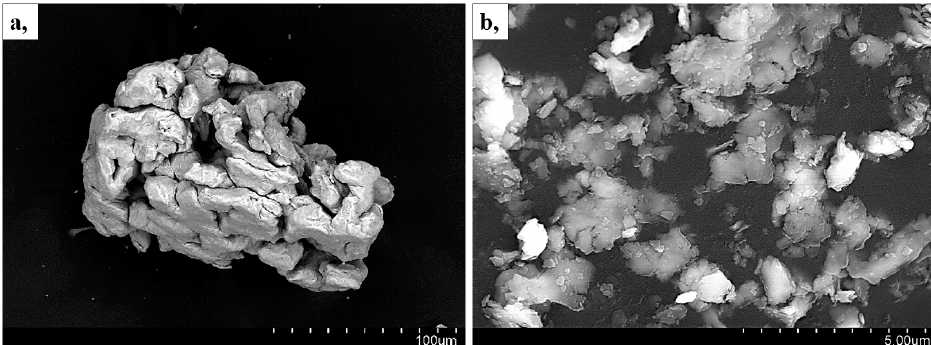
Figure 2. ( a , b ) Show the morphology of the initial and the milled Ti powders, respectively. Table 2. Chemical composition of initial and milled Ti powder (wt.%).